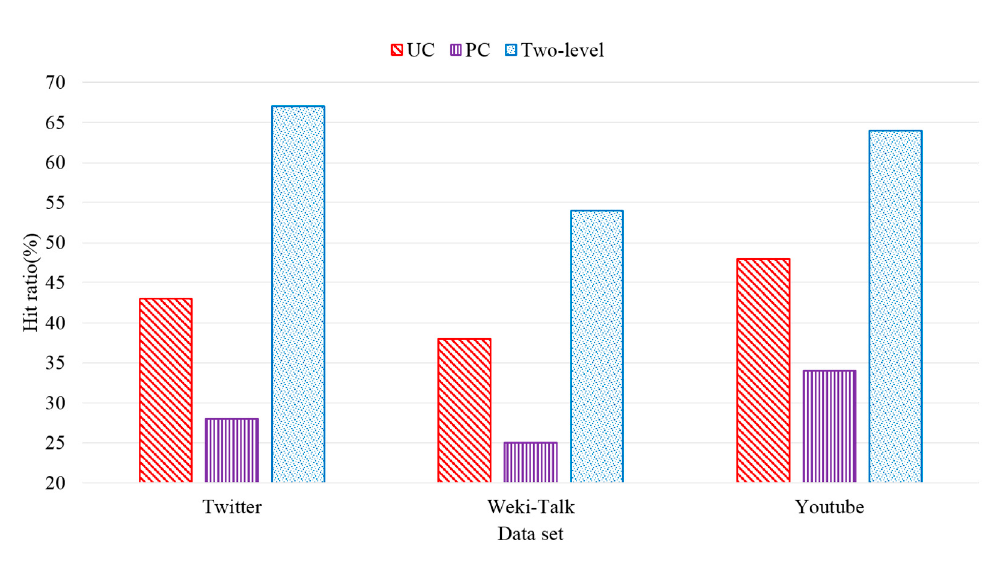
Figure 10. Hit ratio of single and two-level caches.